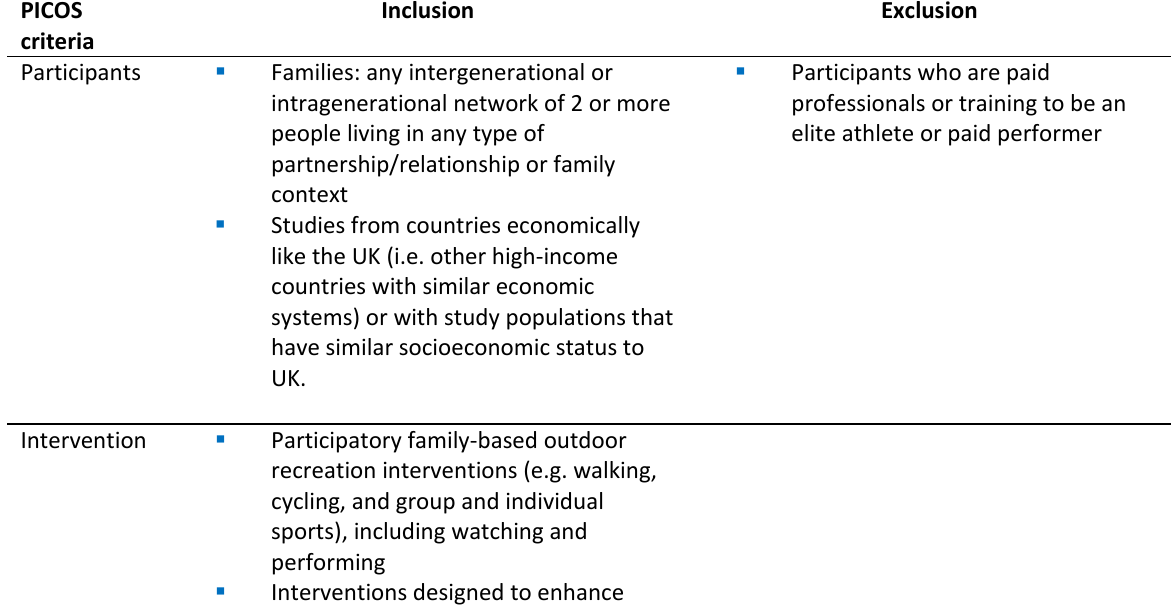
Table 1 Eligibility criteria